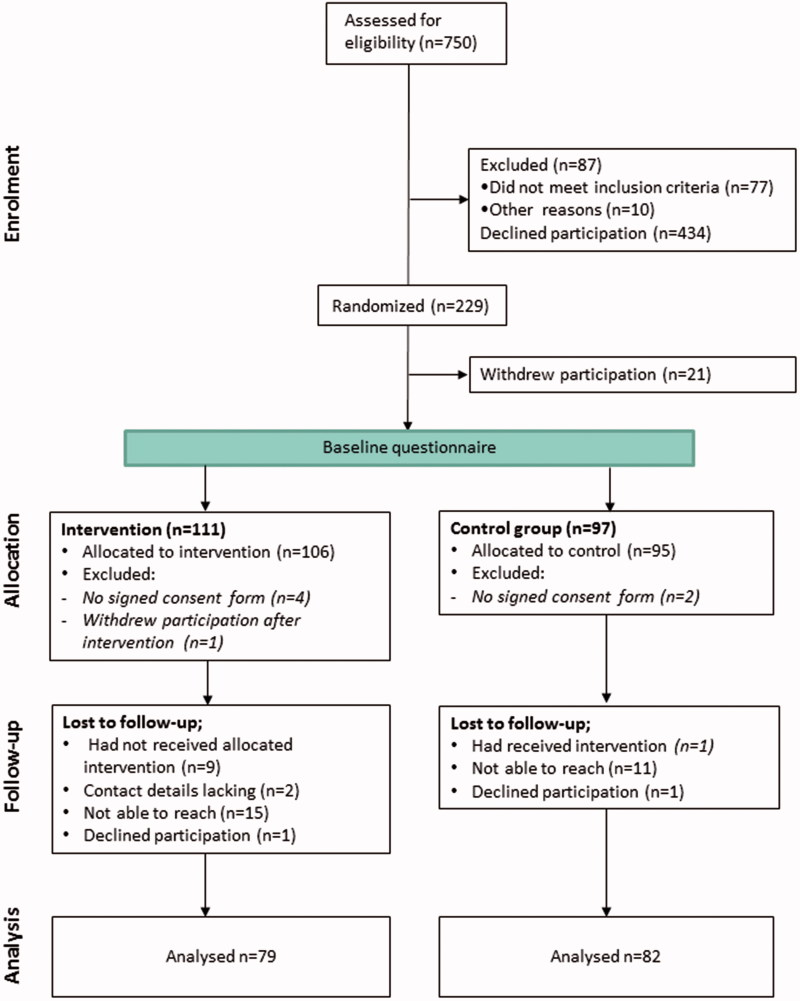
CONSORT flowchart.